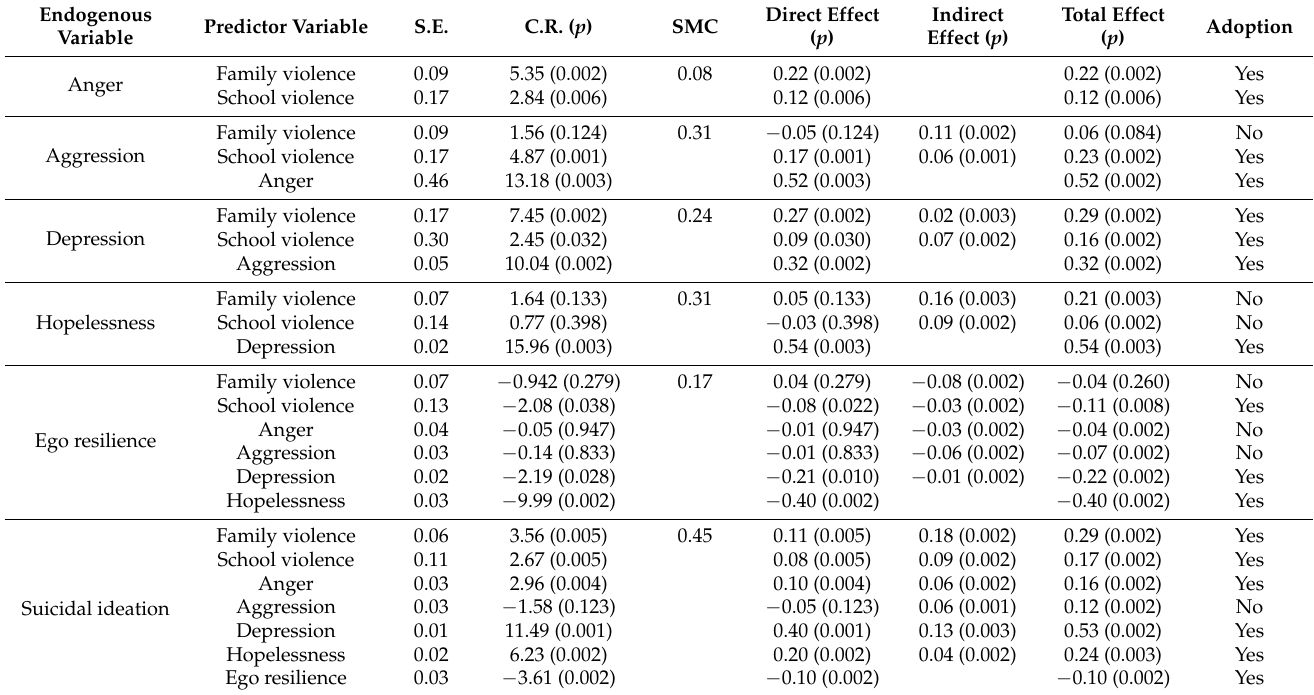
Table 4. Standardized estimates, construct reliability (CR); Squared multiple correlation (SMC); and standardized direct, indirect, and total effect for the hypothetical model ( n =